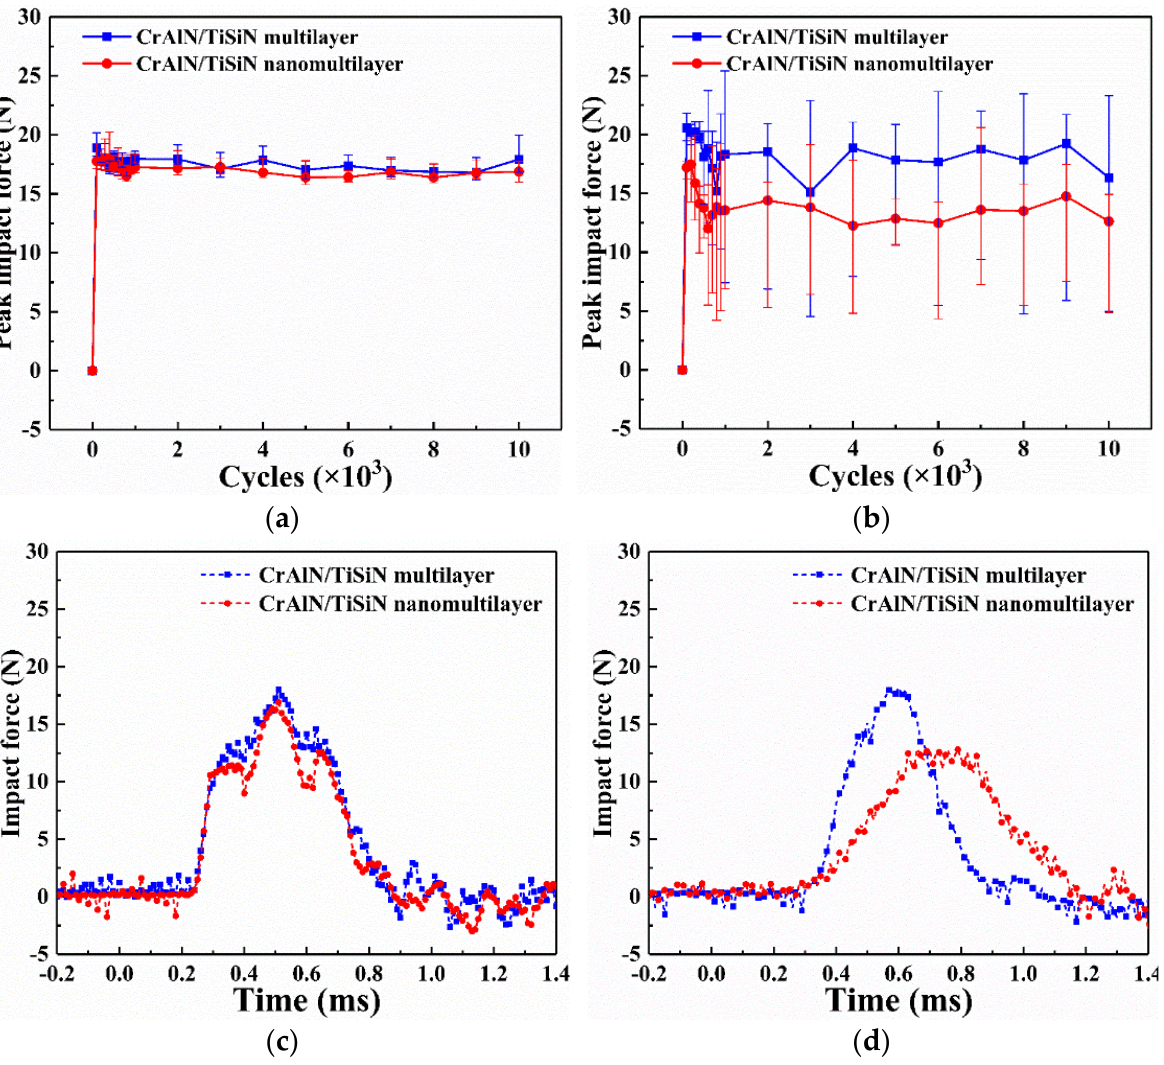
Figure 8. Impact force response of the two CrAlN/TiSiN coatings under various conditions. ( a ) No sand; ( b ) Sand; ( c ) No sand at 10 4 cycles; ( d ) Sand at 10 4 cycles.